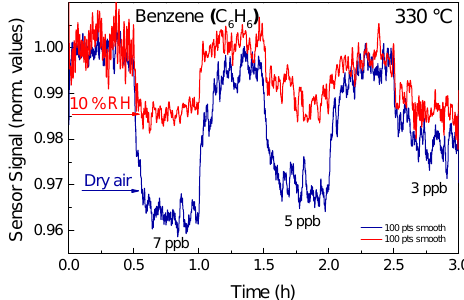
Figure 9. Sensor response to low concentrations of benzene (C 6 H 6 ) from 7 to 3ppb at 330 ◦ C in dry air and under 10% relative humidity (RH). The sensor signal is filtered to reduce the electronic noise. The value 100pts smooth is equivalent to a sampling time of